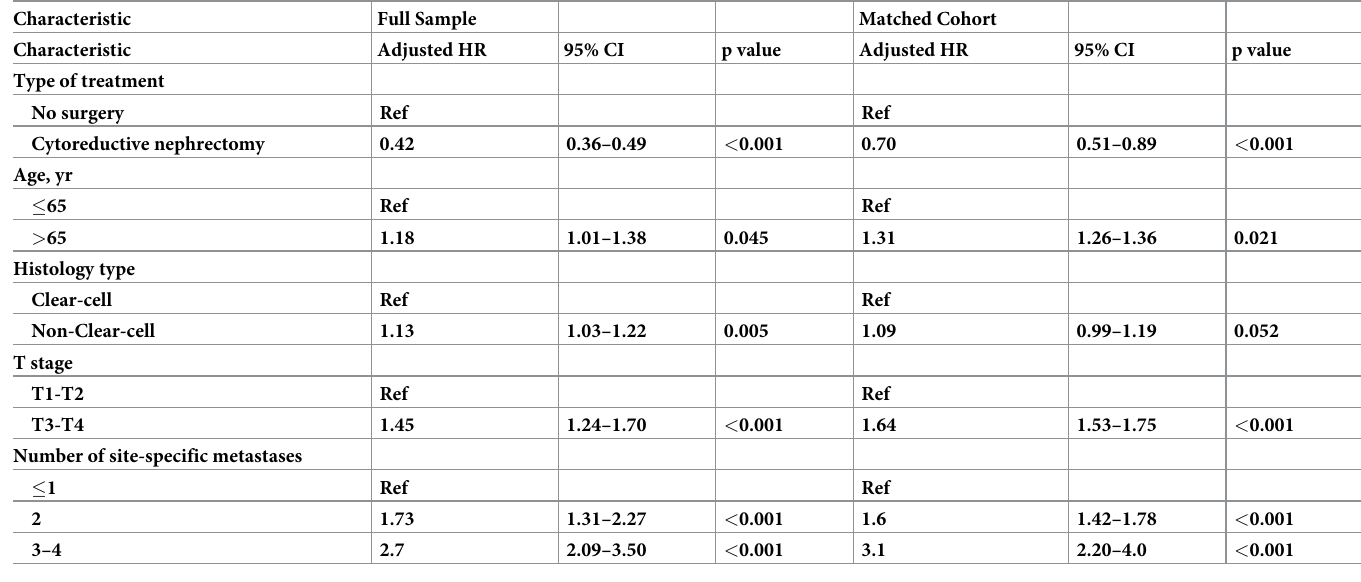
Table 2. Stepwise multivariable competing risks regression analysis of cancer specific mortality in patients with metastatic RCC at diagnosis.